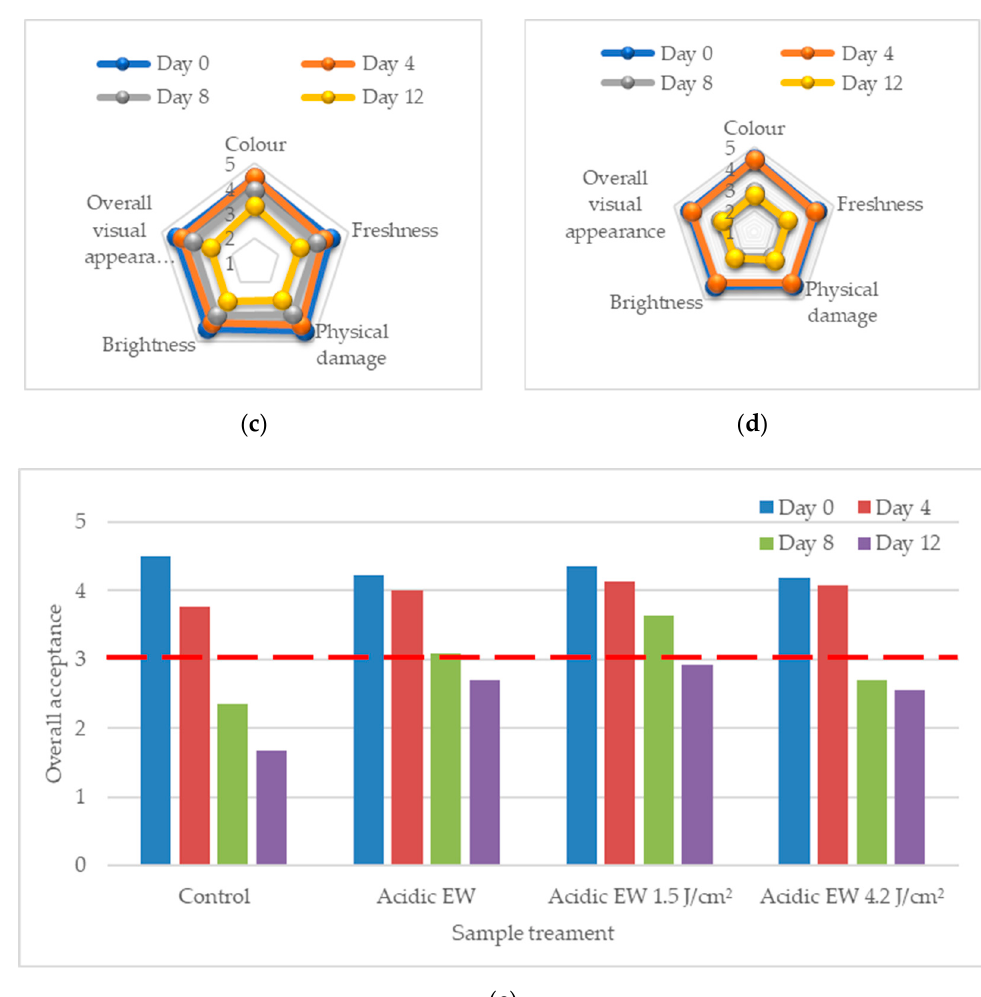
Figure 1. The spiderweb chart of sensory evaluation scores of fresh-cut pennywort leaves ( a ) un- treated (tap water), ( b ) acidic electrolysed water, ( c ) PL + AEW treatment 1.5 J/cm 2 , ( d ) PL + AEW treatment 4.2 J/cm 2 , ( e ) mean values for the overall acceptance.